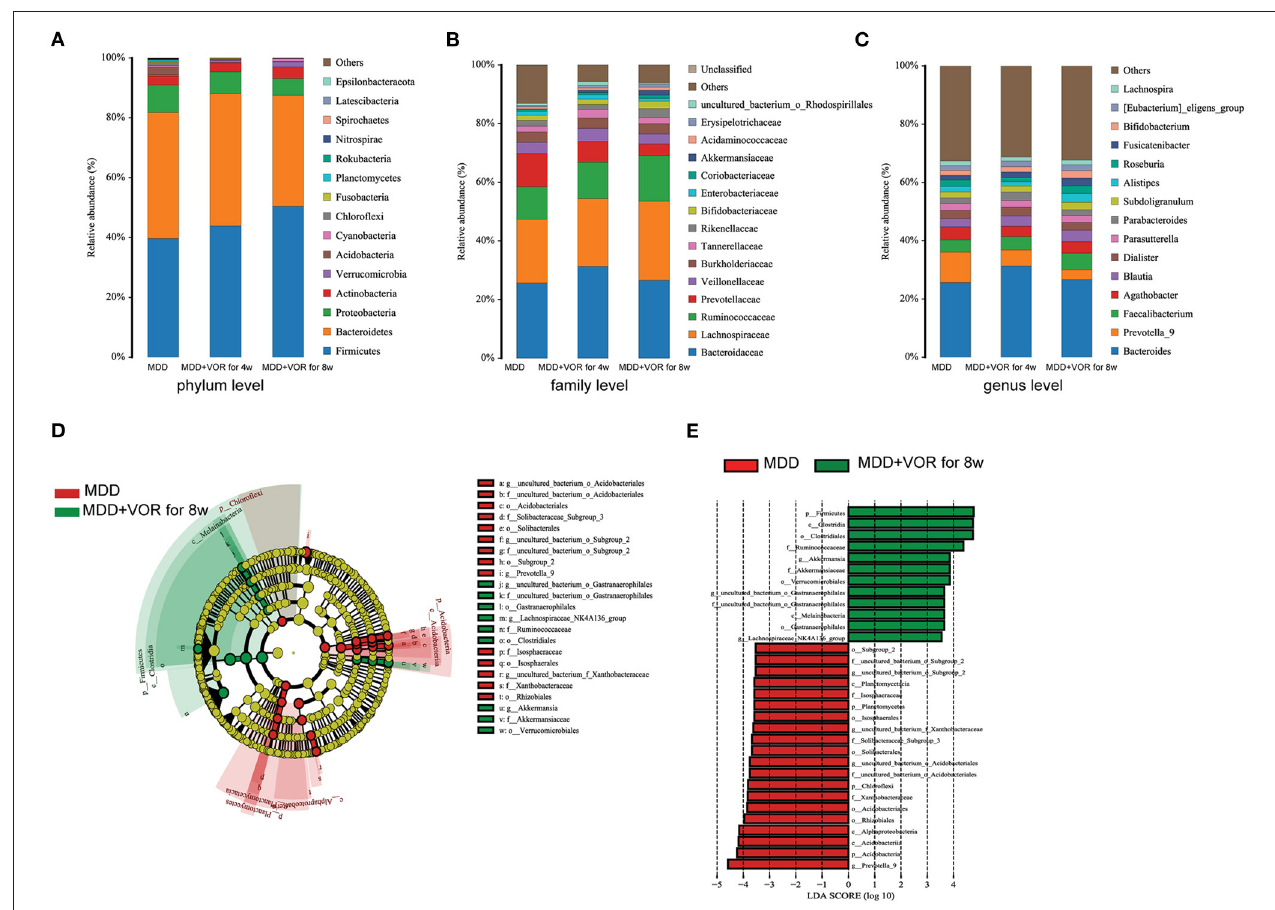
FIGURE 5 | Taxonomic differences in the fecal microbiota between MDD patients before and after treatment. Comparison of relative abundance at the bacterial phylum (A) , family (B) and genus (C) levels before MDD treatment, MDD + VOR for 4 weeks, MDD + VOR for 8 weeks. LEfSe identified the most differentially abundant taxa between MDD + VOR after 8 weeks and before MDD treatment. The brightness of each dot is proportional to its effect size (D) . Taxa enriched before MDD treatment are indicated with a negative logarithmic discriminant analysis (LDA) score (red), and taxa enriched after 8 weeks of treatment (MDD + VOR for 8 weeks) have a positive score (green). Only taxa meeting an LDA significance threshold > 3.5 are shown (E)